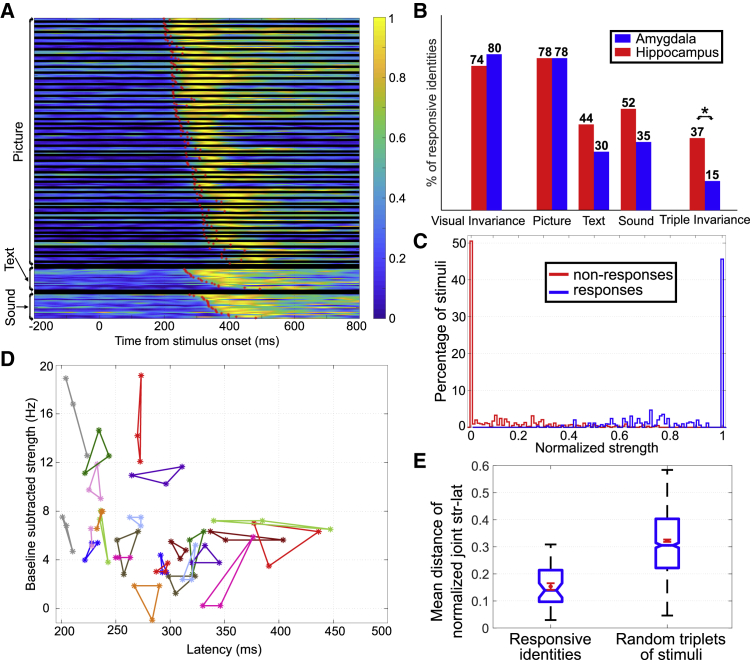
Response Characteristics of the Population of Recorded Cells(A) Normalized firing rate for all response-eliciting stimuli, separated by stimulus type (picture, text, and sound). Within the pictures, the 47 response-eliciting identities are separated by black lines and sorted by their shortest latency. Response latency for each stimulus is denoted by a red star. Figure S2 shows a neuron with 15 response-eliciting stimuli from three different identities.(B) The proportion of response-eliciting identities was evaluated in different conditions and segregated between the units in the hippocampus and amygdala. In both regions, similar proportions were found for visual stimuli (for visual invariance and for the proportion of identities showing responses to more than one picture), but larger proportions in the hippocampus were seen for text and sound stimuli. In the case of triple invariance, i.e., identities showing visual invariance and responses to the text and sound stimuli, the proportion of identities in the hippocampus was significantly larger than in amygdala (Z test, p < 0.05).(C) Histograms for the normalized strength of activity in all the responsive units, computed for all the stimuli presented in each session and separated according to whether or not they were responsive.(D) Strength (baseline corrected) and latency for each picture in 25 out of the 47 response-eliciting identities (the remaining 22 are presented in Figures S3A and S3B). Each triplet associated to a given identity is depicted as a triangle of a given color with each picture corresponding to the vertices of the triangle.(E) Average joint distance (in the strength-latency space presented in Figure 3D) for the three pictures of a given identity (left), and triplets created by randomly selecting three pictures out of the 141 pictures (right). Mean ± standard error of the mean is shown in red, while boxplots are in blue (center line, median; box limits, upper and lower quartiles; notch limits, (1.57 × interquartile range)/sqrt(n)) with the whiskers in black extending to the most extreme data points not considered as outliers. There were significant differences between the two populations (rank-sum test, p ∼10−17).See Figures S3E and S3F for the independent analysis of strength and latency.